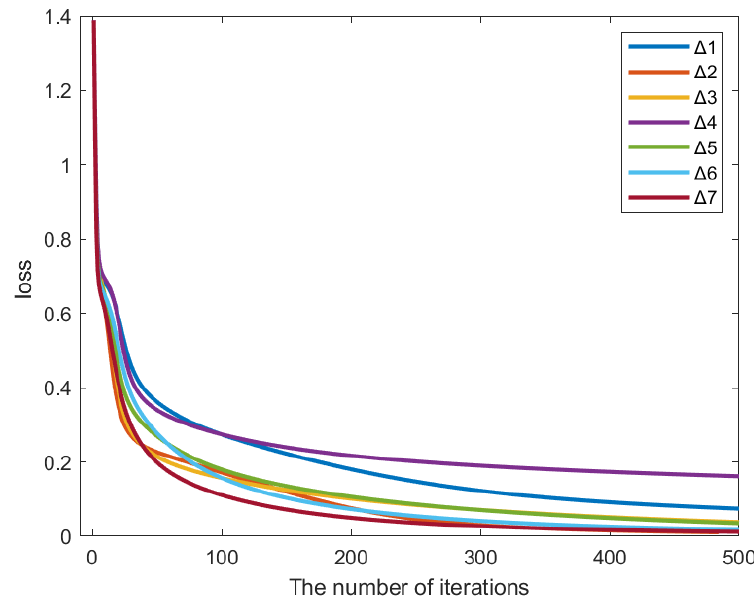
Figure 13. Loss curve of the network training process.